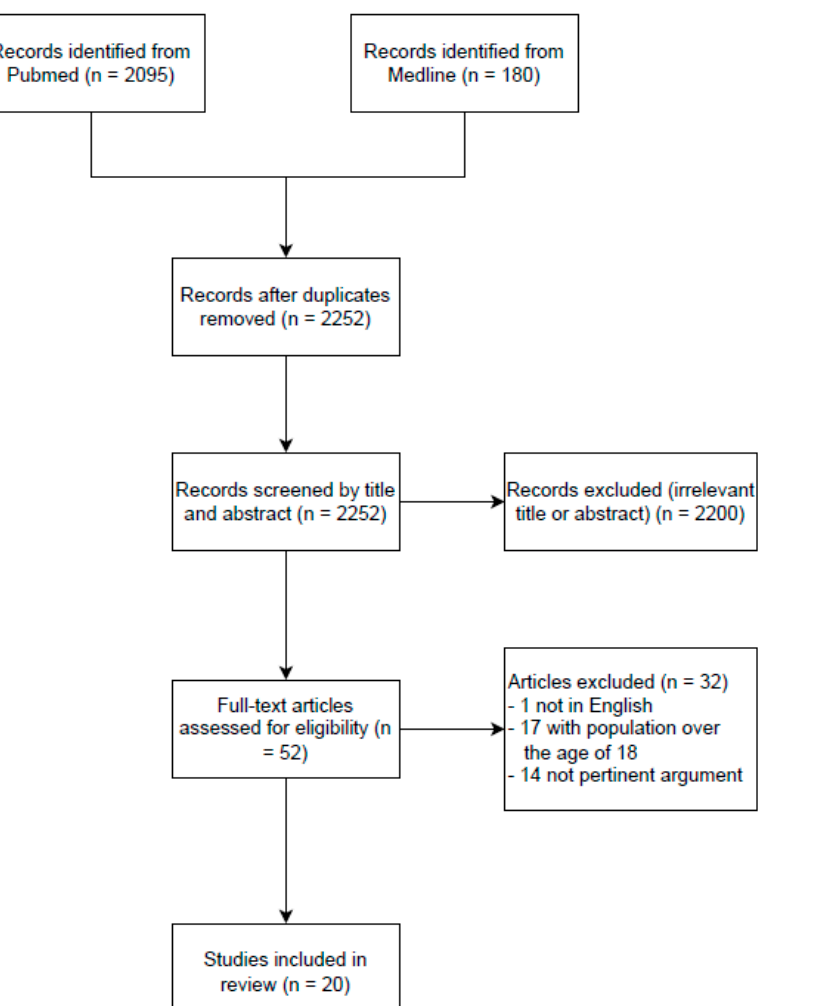
Figure 1. Flow of information through review.